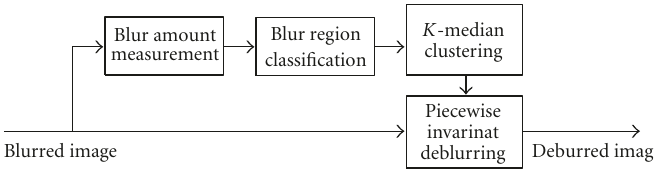
Figure 8: Shift variant deblurring